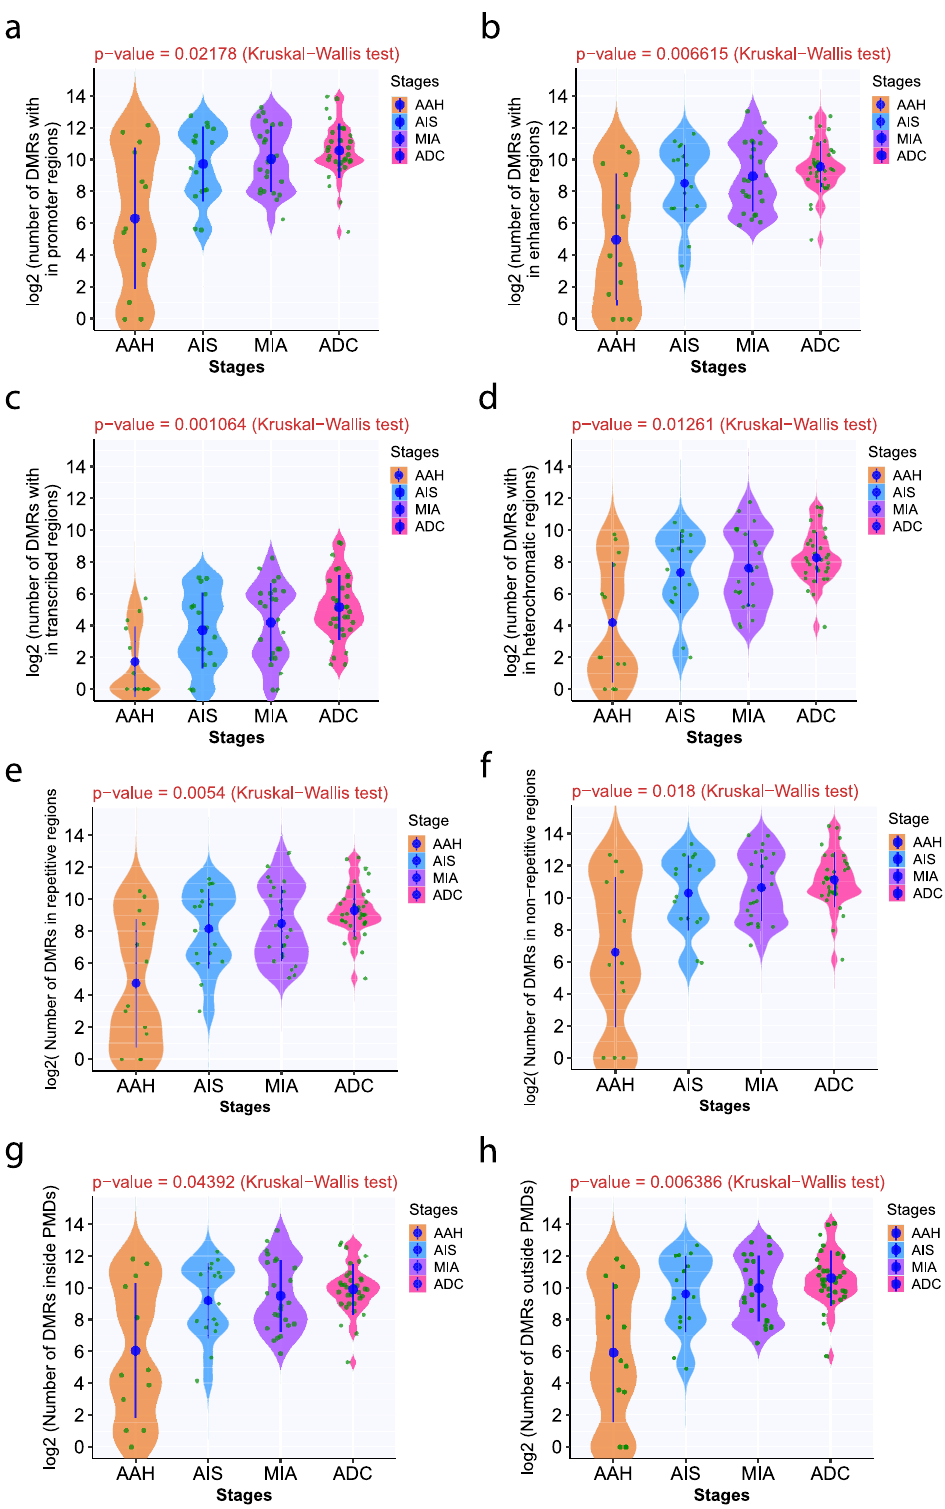
Fig. 2 The number of DMRs in IPNs of different stages by genomic regulatory regions and PMDs. The number of DMRs are shown in promoters ( a ), enhancers ( b ), transcribed regions ( c ), repressed regions (heterochromatin) ( d ), repetitive regions ( e ), non-repetitive regions ( f ), inside PMDs ( g ), and outside PMDs ( h ). The solid blue dots represent the means of normalized numbers of DMRs in IPNs of each histologic stage with a 95% con fi dence interval as error bars. The differences among all stages were assessed using the Kruskal-Wallis H test. Source data is provided as a source data fi